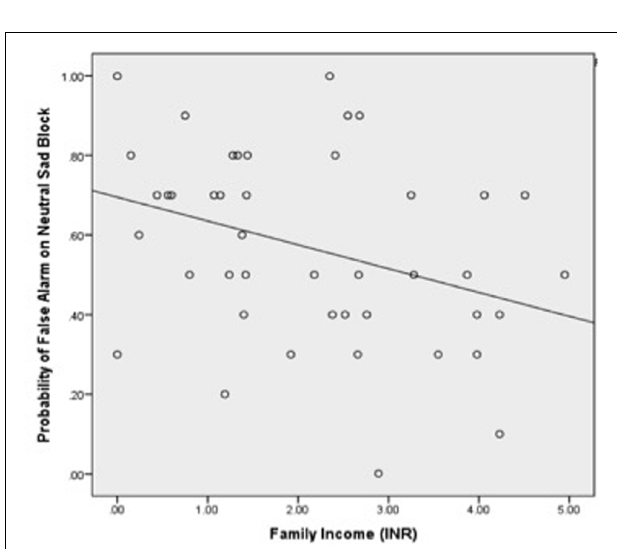
FIGURE 3 | Relationship between family income and the probability of false alarm rates during Sad “NoGo” distracter trials, b = − 0.34, p <